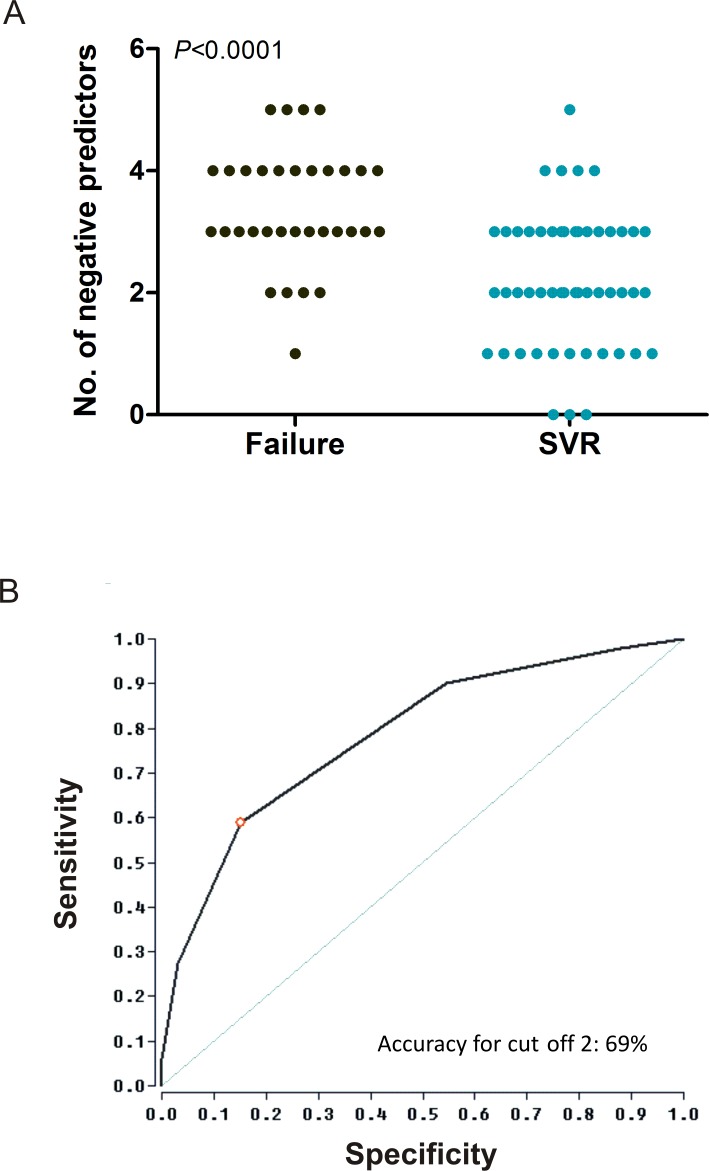
Analysis of negative predictors of treatment response.A) Scatter plot of negative predictors stratified by treatment outcome. Several negative predictors known from the literature (IFNL4 non-CC genotype, HCV subtype 1a, high HCV viral load and IP10 levels, the presence of cirrhosis, BOC/TVR-resistant RAVs and phenotypes) were investigated in a subgroup of patients with available NS3 phenotypes. B) ROC analysis for defining a cut-off for the number of negative predictors. Thereby, 2 or less negative predictors correspond to a specificity of 85% and a sensitivity of 59% for predicting SVR.